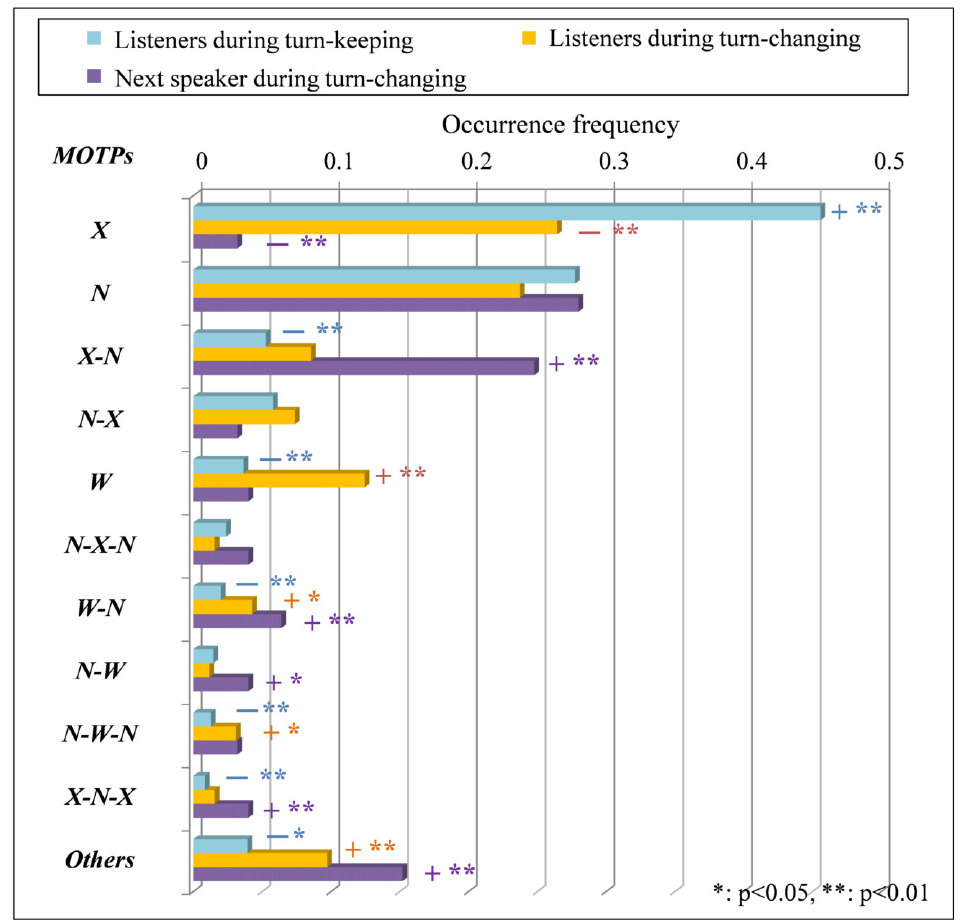
Figure 5. Occurrence frequency of MOTPs of listeners during turn-keeping and turn-changing and next speaker during turn-changing. Vertical axis indicates the type of MOTP. Numerical value on the horizontal axis indicates the occurrence frequency of each MOTP. Light blue bars show the data of listeners during turn-keeping and orange bars show the data of listeners during turn-changing. Purple bars show the data of next speaker during